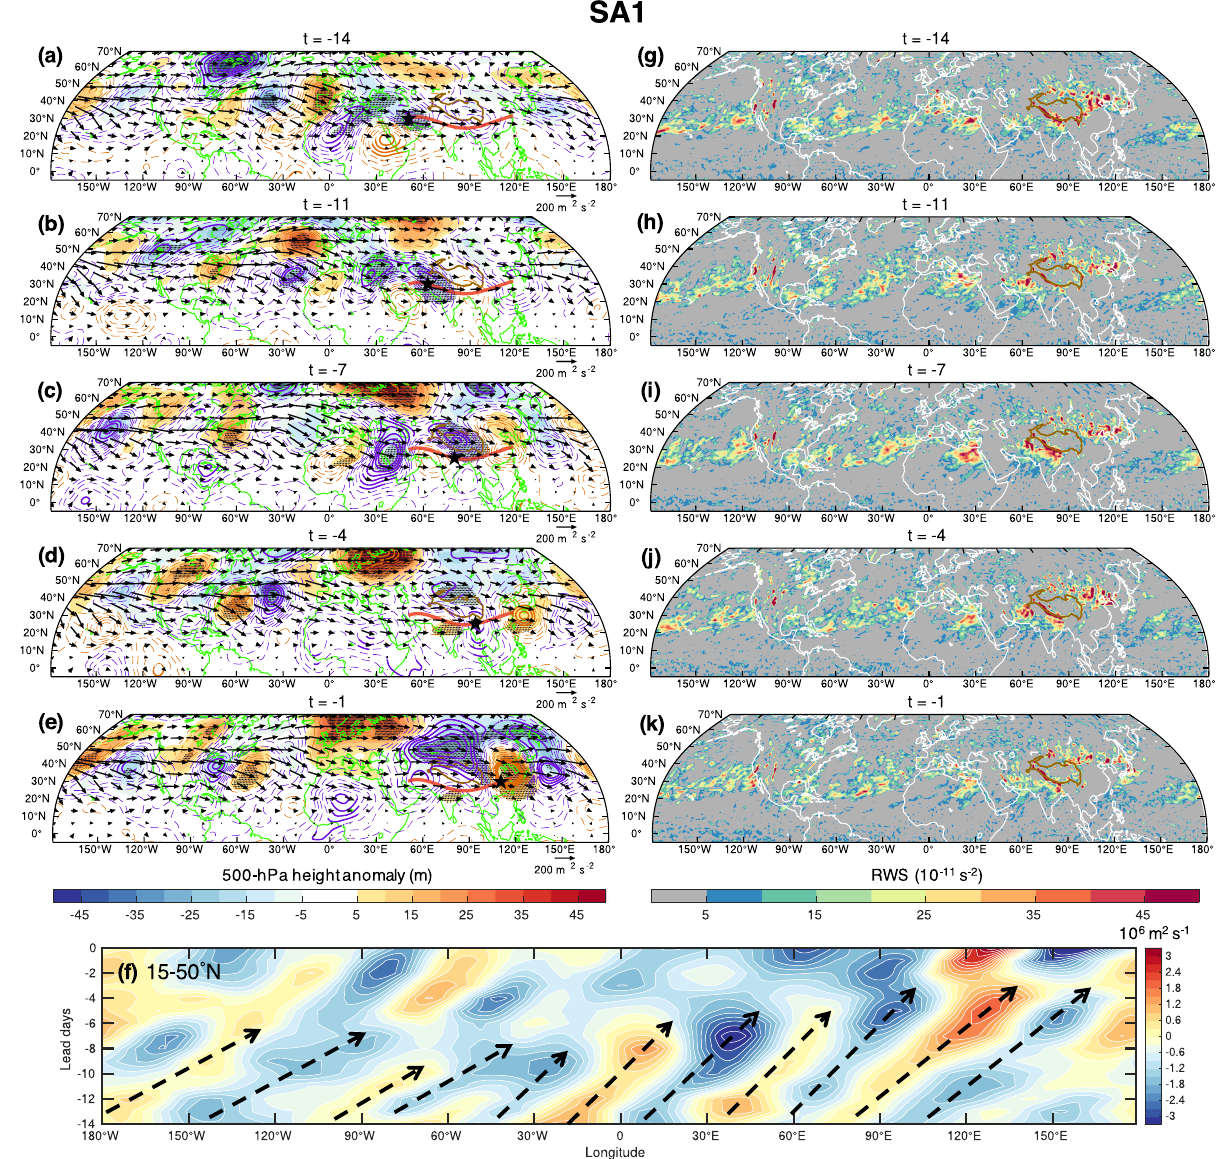
streamfunction (contour, interval: 4 × 10 5 m 2 s − 1 ) from day − 14 to − 1. Contours in orange (purple) denote positive (negative) values. The solid red line represents the regressed moisture channel for the cluster, and the black star denotes the moist air column ’ s position along the regressed channel. Black dots over the shading and thick contours denote statistically signi fi cant values at the 0.05 level (Student ’ s t -test). f Time-longitude plot of the meridionally averaged (15 – 50°N) 200-hPa perturbation streamfunction (shading, unit: 10 6 m 2 s − 1 ). The dashed arrows guide the propagation of the wave peaks. g – k The Rossby wave source (RWS) (shading, unit: 10 − 11 s − 2 ) from day − 14 to −